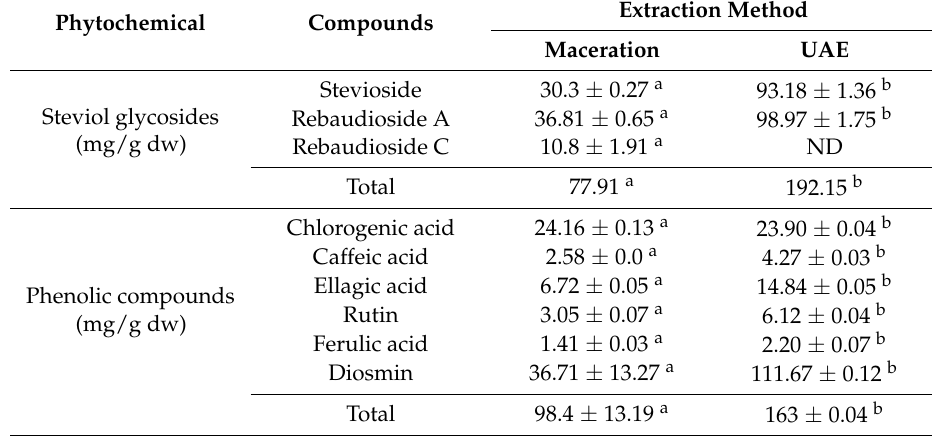
Table 2. Steviol glycosides and polyphenol content of maceration and ultrasound assisted extraction (UAE)